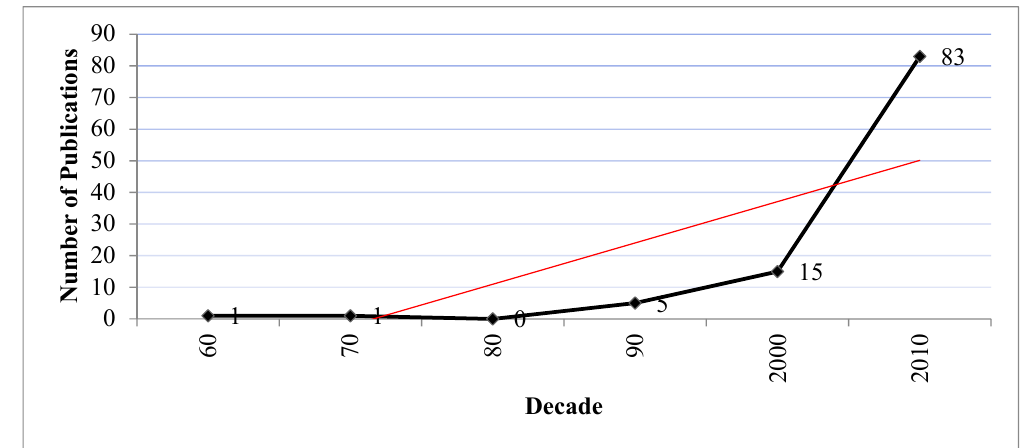
Figure 1. PRISMA flow diagram illustrating the literature research and selection process.